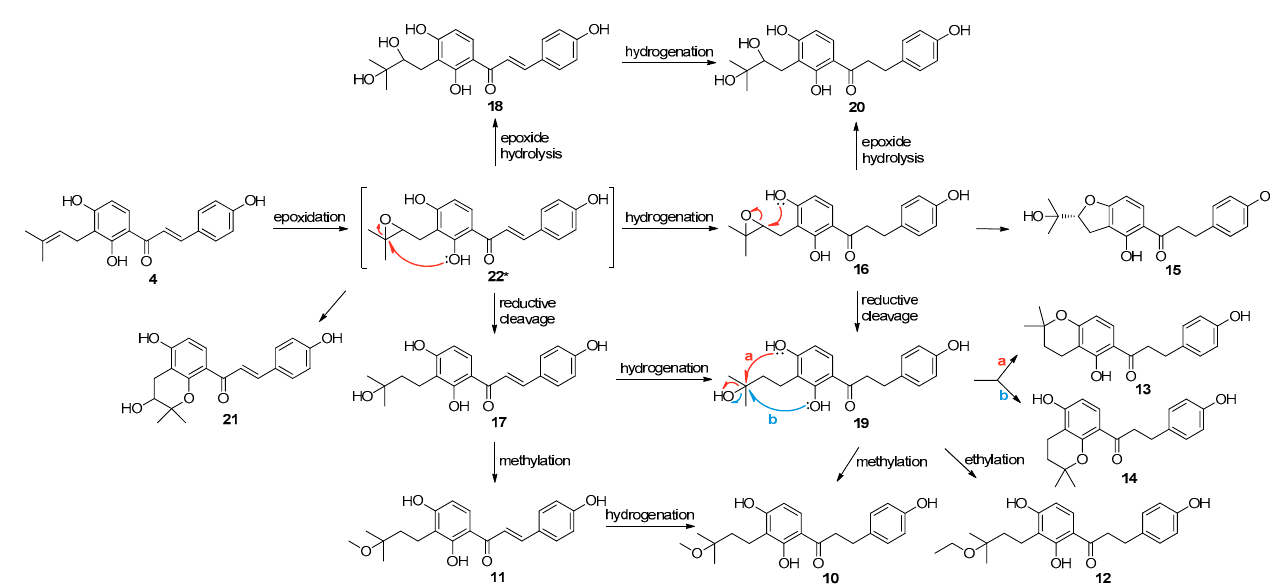
Figure 4. Proposed metabolic pathways of 4 catalyzed by A. niger . Pathways a and b, represented by the arrows in red and blue respectively, are proposed as the two routes to form a new ring in compound 19 . *Compound 22 is proposed as an intermediate which could not be unambiguously identified in this study.